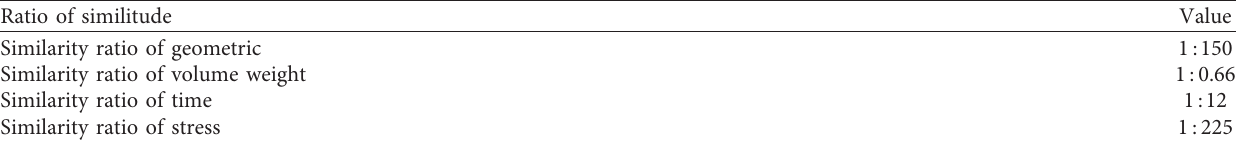
Table 2: Similarity ratio of each parameter.